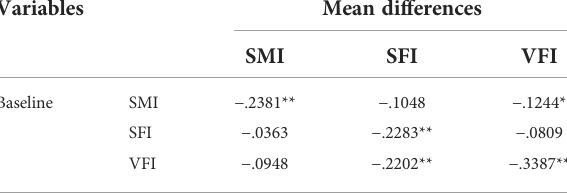
TABLE 4 Associations between body composition changes. Variables